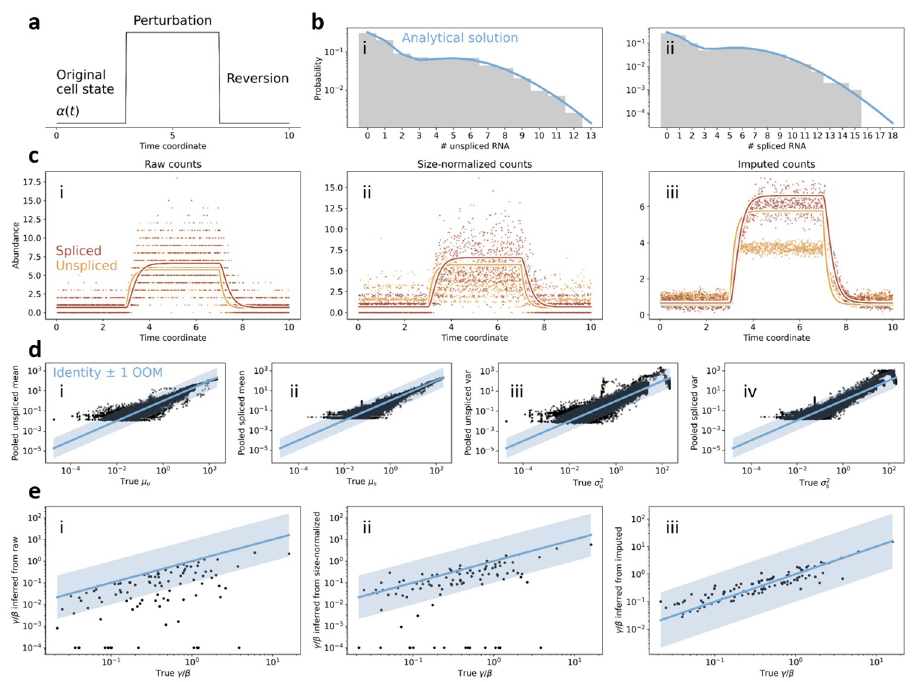
Fig 9. The RNA velocity count processing and inference workflow, applied to data generated by stochastic simulation. a. Schematic of the impulse model of gene modulation. b. Demonstration of the concordance between simulation and analytical solution for the occupation measure. i. : nascent mRNA counts; ii. : mature mRNA counts (gray: simulation; blue: occupation measure). c. Smoothing and imputation introduce distortions into the data. i. : raw data; ii. : data normalized to total counts; iii. imputed data (points: raw or processed observations; lines: ground truth averages μ s and μ u ; red: spliced; yellow: unspliced). d. Local averages obtained by imputation are not interpretable as instantaneous averages. i. : mean unspliced; ii. : mean spliced; iii. variance unspliced; iv. : variance spliced (black points: true moment vs. pooled moment; blue line: identity; blue region: factors of ten around identity). e. Smoothing and imputation improve the inference on extrema. i. : moment-based inference from raw data; ii. : extremal inference from normalized data; iii. : extremal inference from imputed data (black points: true vs. inferred values of γ / β ; blue line: identity; blue region: factors of ten around identity). The palette used is derived from dutchmasters by EdwinTh.